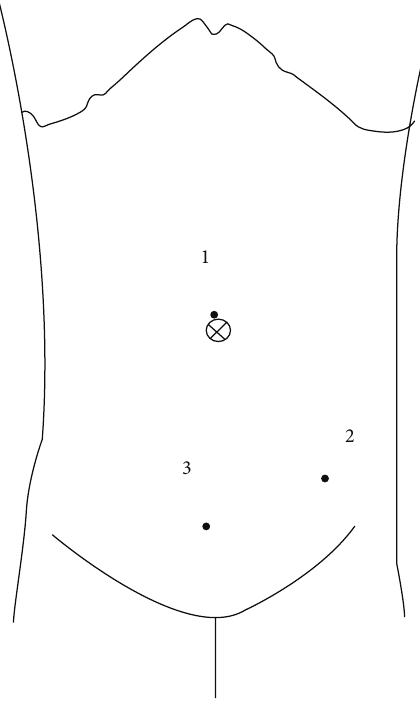
Figure 1: Ports placement.